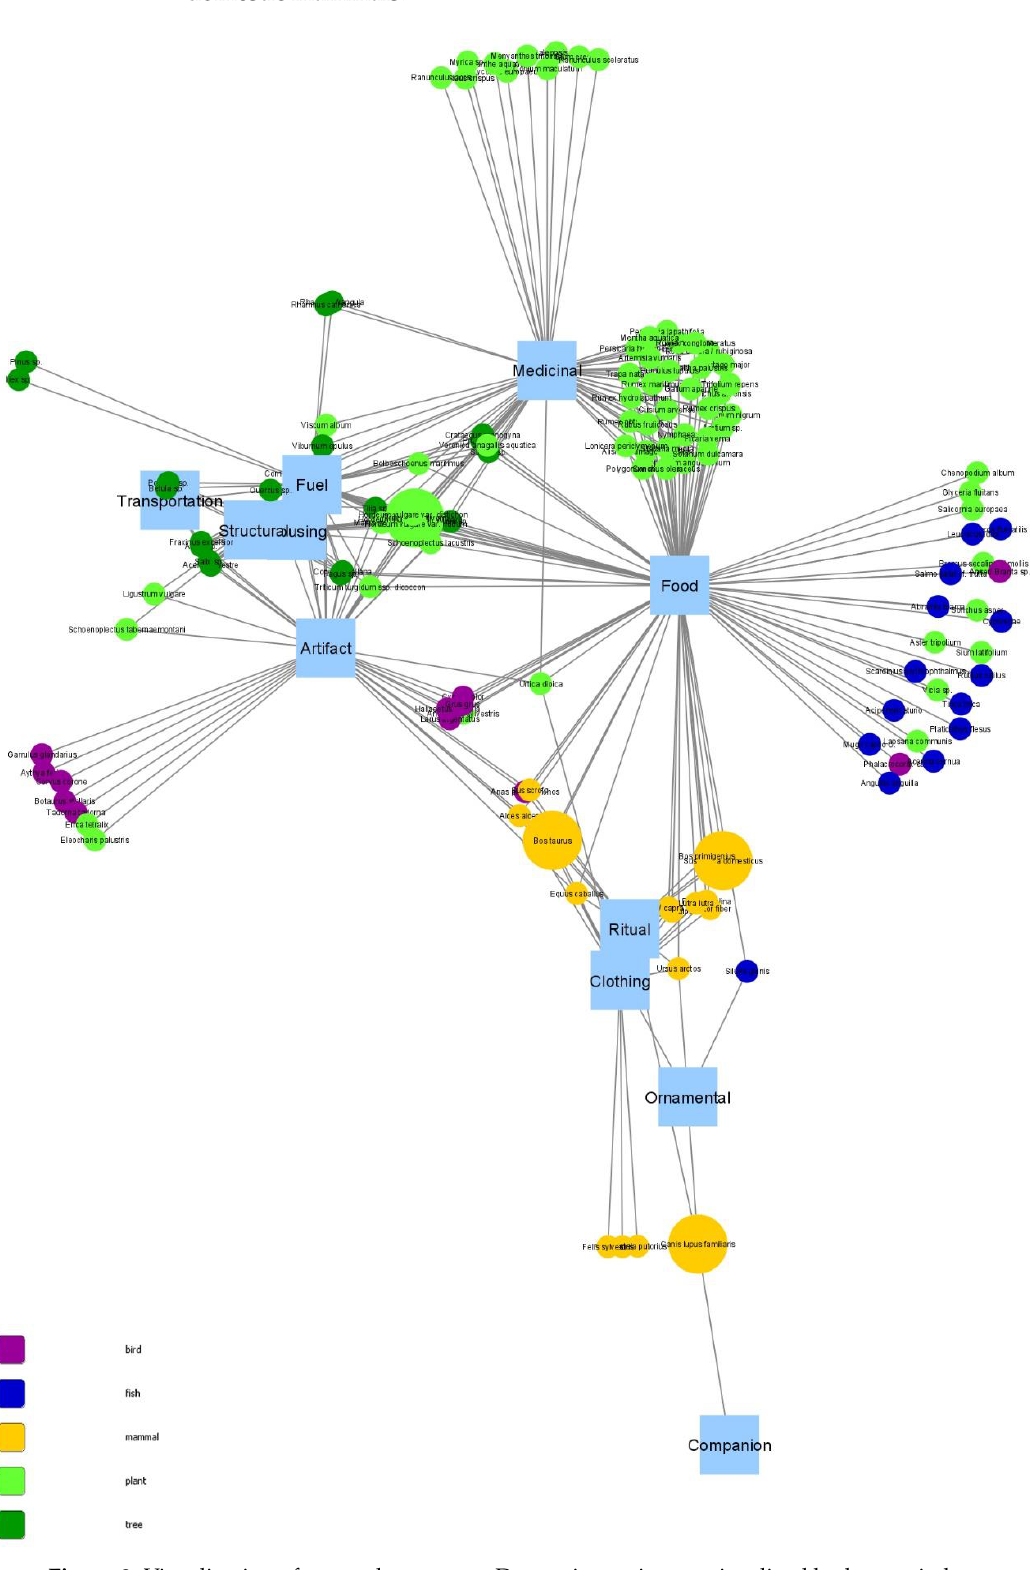
Figure 8. Visualization of network structure. Domestic species are visualized by larger circles.